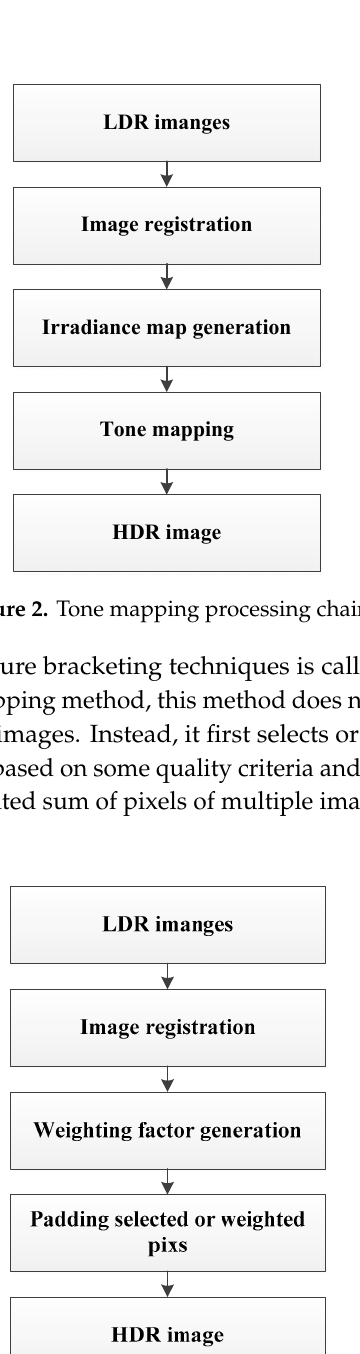
Figure 3. Exposure fusion processing chain.